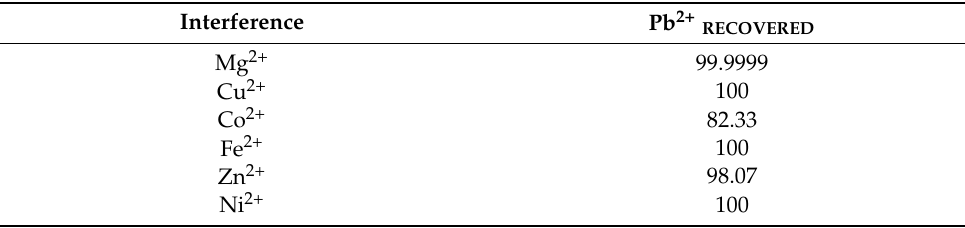
Table 8. The interference of other metals to the simultaneous detection of the three-target analyte